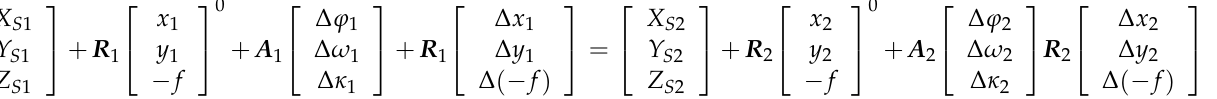
from the interior calibration parameters of the left chip and is the image point coordinate error for p 1 on the left chip. ( ∆ x 2 , ∆ y 2 ) is calculated by the interior calibration parameters of the right chip and is the image point coordinate error of p 2 on the right chip. The interior calibration parameters for each chip differ from each other. Equation (13) can then be simplified to the